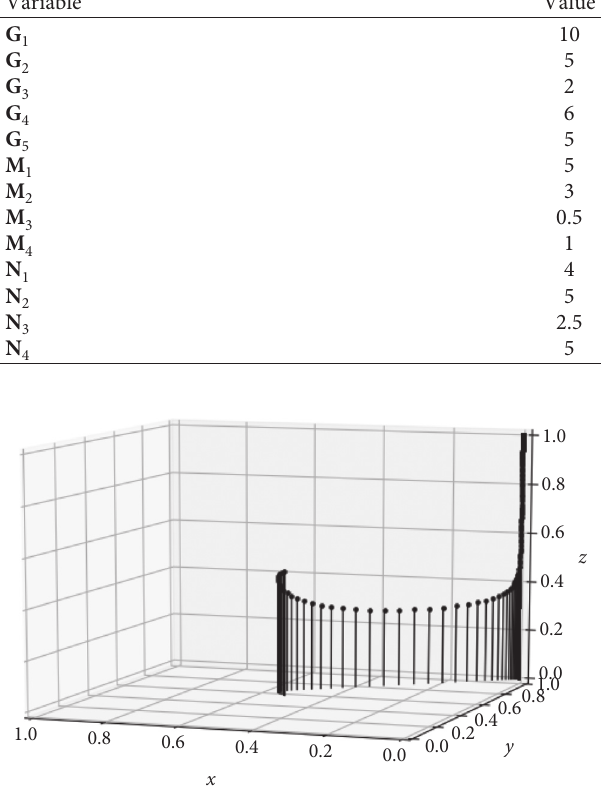
Figure 6: Stable evolution trajectory of local government, new media, and local people.